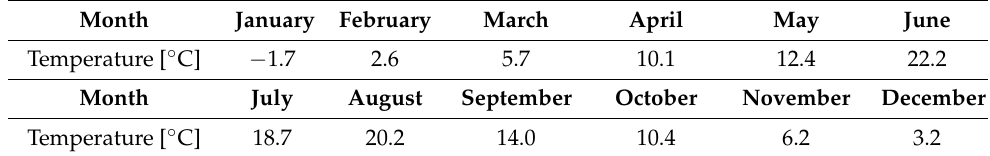
Table 1. Average monthly temperatures in 2019 for Lodz (own study based on data from source: [36]).